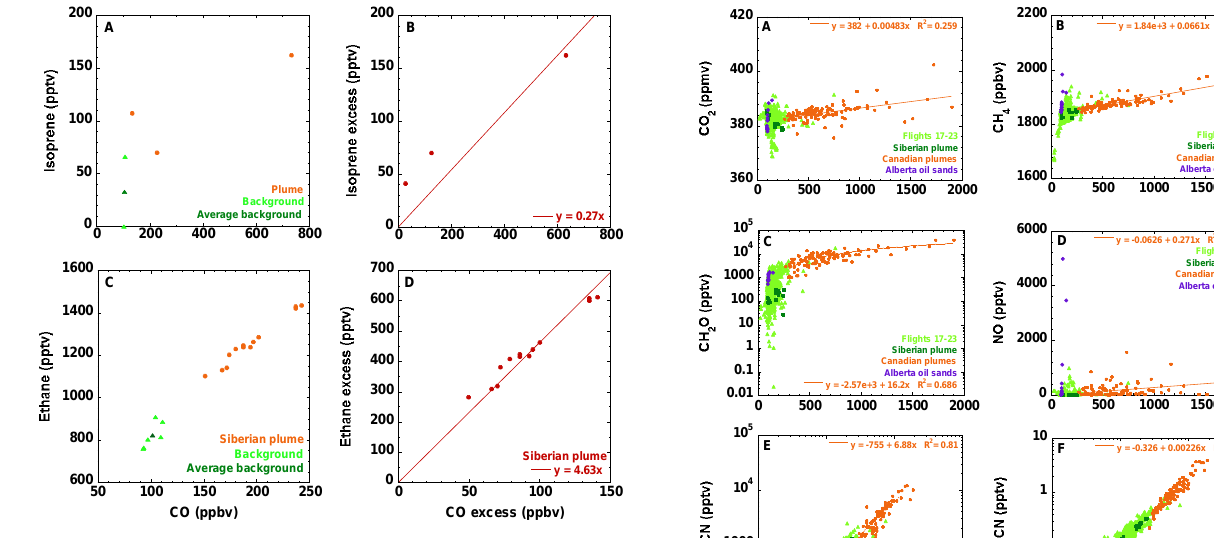
Figure 3. As in Figure 2 but for (a-b) isoprene using samples selected for the analysis of short- Fig. 3. As in Fig. 2 but for (a–b) isoprene using samples selected for the analysis of short-lived compounds, and for (c–d) ethane using lived compounds, and for (c-d) ethane using biomass burning samples from the Siberian plume biomass burning samples from the Siberian plume (see text). (see text).